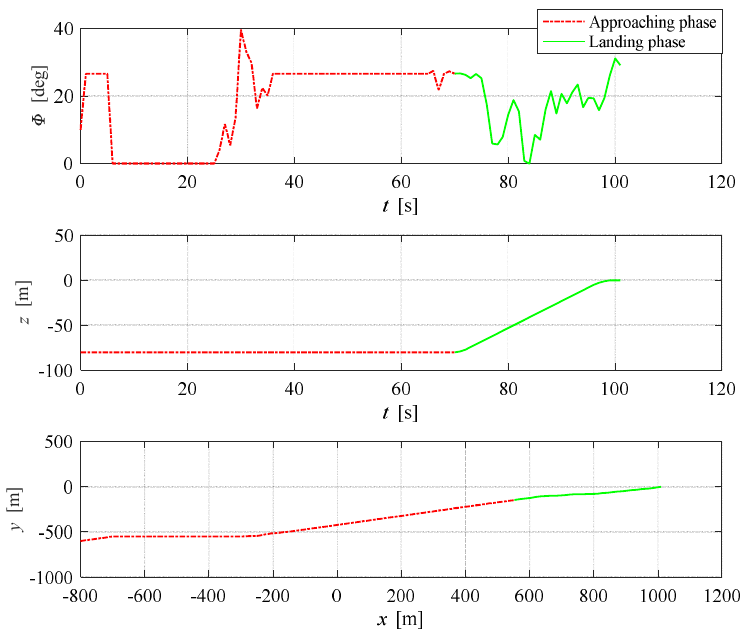
Figure 9. State of the helicopter in the landing task considering the moving of the carrier.